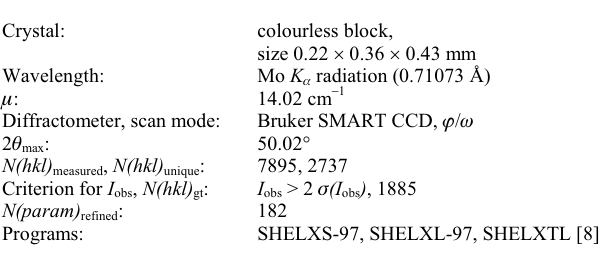
Table 1. Data collection and handling.